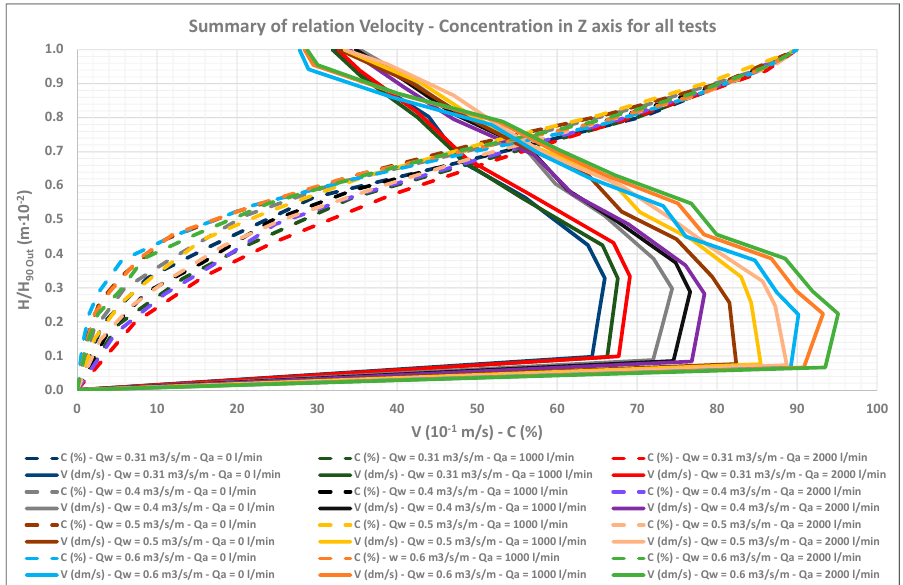
Figure 11. Summary of relations between velocity and concentration profiles in all scenarios. Table 2. Average velocity, concentration and H 90 values at the channel exit.